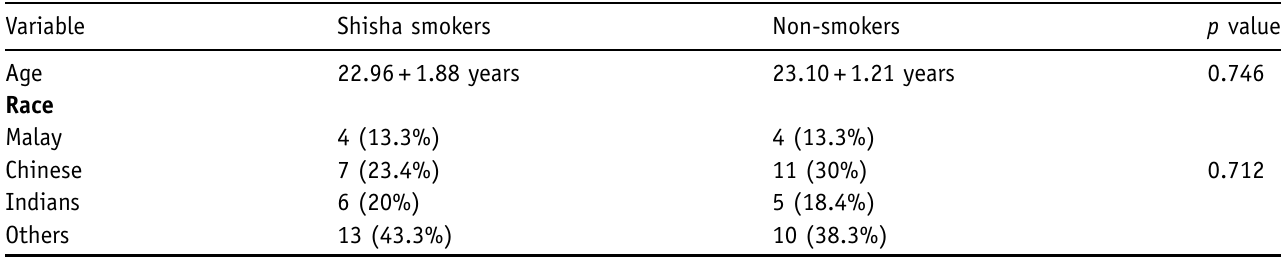
Table I. Demographic distribution of study